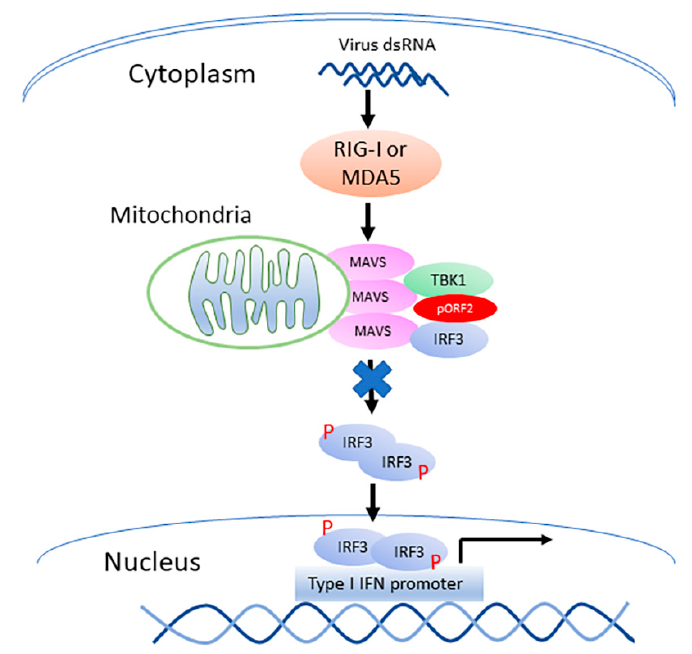
Figure 9. Model for the capsid protein inhibition of TBK1-mediated IRF3 phosphorylation. “P” denotes phosphorylation of IRF3. The capsid protein is denoted by “pORF2”. “X” on the arrow from MAVS to IRF3 indicates blocking the phosphorylation of IRF3.